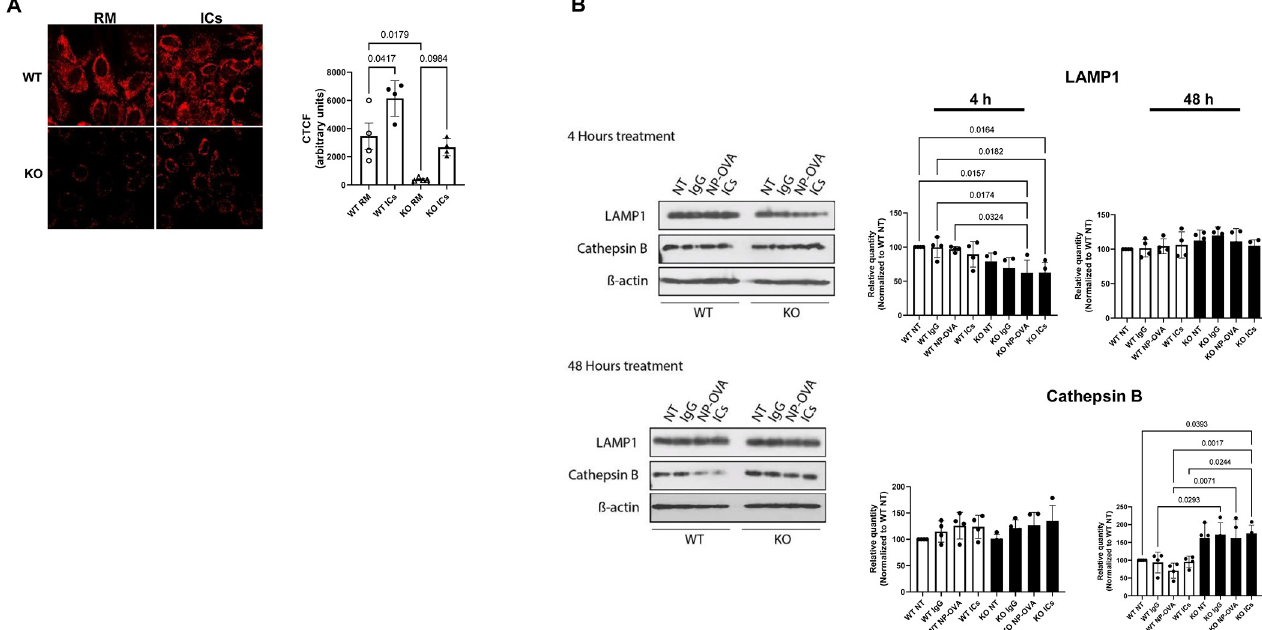
Fig 4. FcRn KO alters lysotracker staining and LAMP1 and cathepsin B expression in podocytes. A , Lysotracker Red staining is significantly decreased in WT and FcRn KO podocytes at baseline and after treatment with ICs. RM, regular media; ICs, immune complexes; CTCF, corrected total cell fluorescence. Symbols represent mean CTCF for 20 different cells, n = 4 independent experiments. B , Western blot analysis of LAMP1 and cathepsin B expression in WT and FcRn KO podocytes treated with IgG alone, NP-ovalbumin or immune complexes for 4 or 48 hours, n = 3 independent experiments.